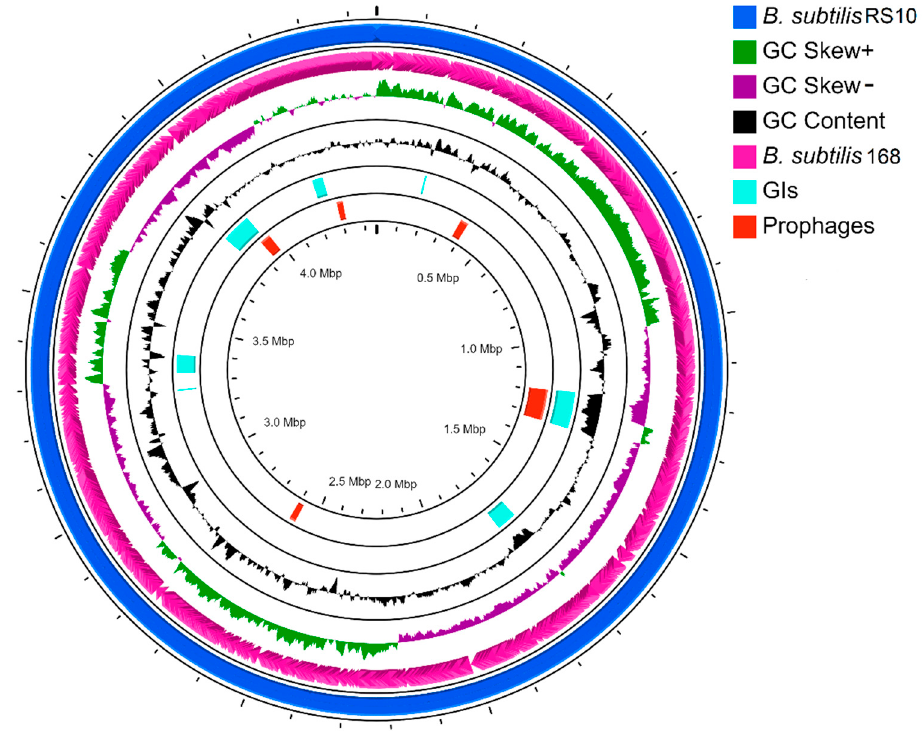
Figure 2. Circular map of the B. subtilis strain RS10 genome. The outermost two circles represent the open reading frame (ORFs) of B. subtilis RS10 and B. subtilis 168, followed by GC content (black). Purple and green colors represent negative and positive strands, respectively. Circle 5th and 6th representing the genomic location of genomic islands (GIs) and prophages, respectively.